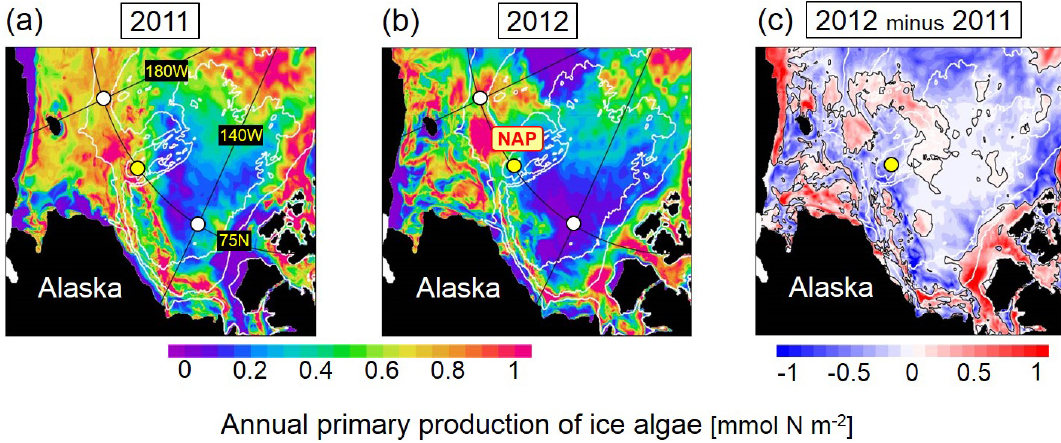
Figure 5. Modeled annual primary production of ice algae in the (a) 2011 and (b) 2012 cases (mmolNm − 2 ) . The difference between the two cases is shown in (c) . Yellow dots denote the location of Station NAP. White dots represent the eastern and western limits of 75 ◦ N section in Fig. 6b–c.